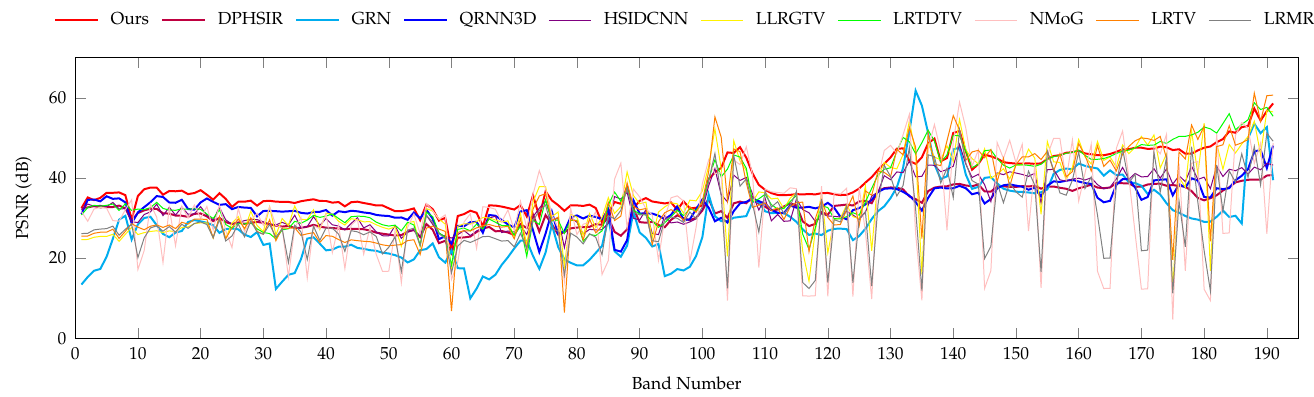
Figure 7. PSNR curves of each band for the images shown Figure 6.